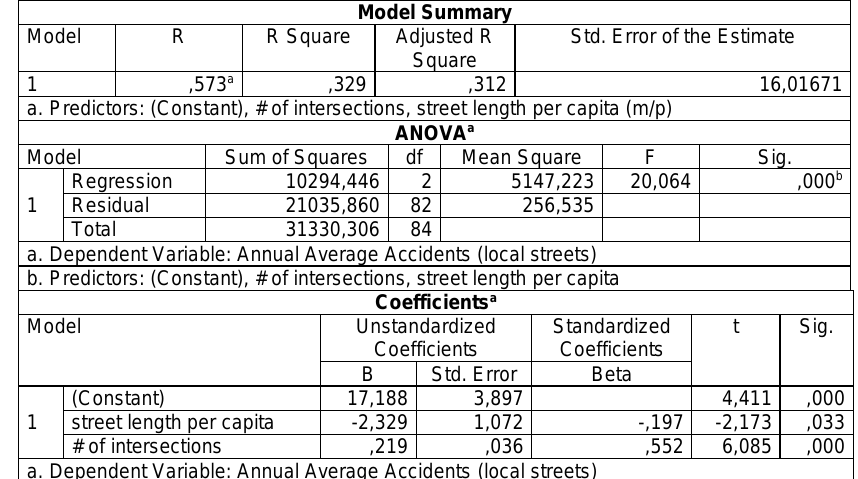
Table 3 Stage 3 Regression Results (Model summary. ANOVA and Coefficients)